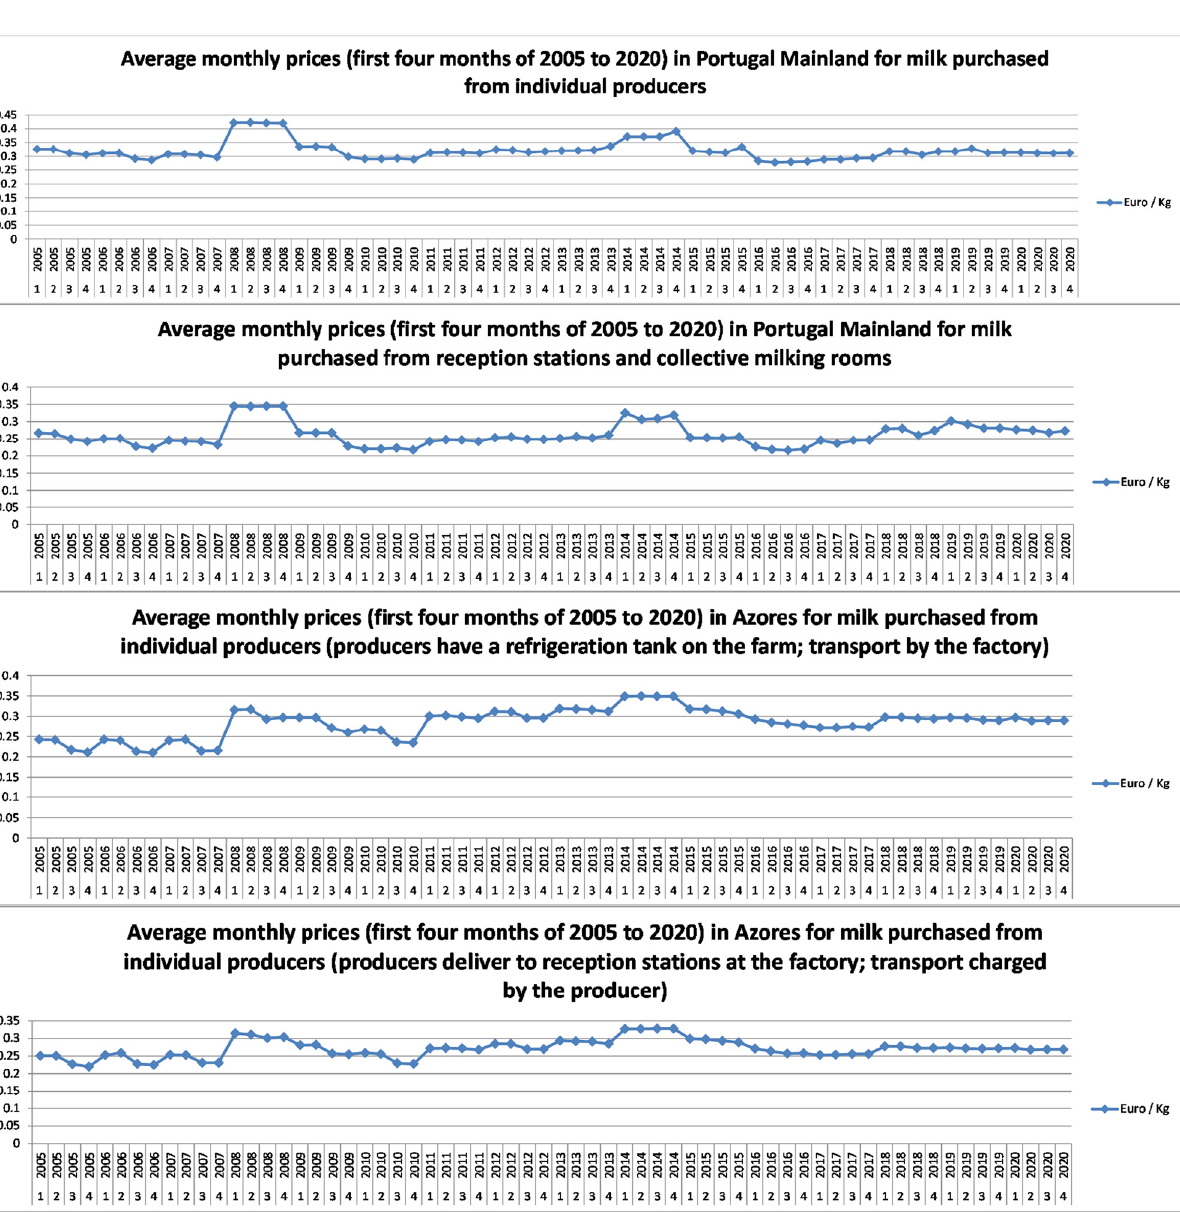
Figure 5: Average monthly prices for the fi rst four months of 2005 – 2020 in the Portuguese Mainland and the